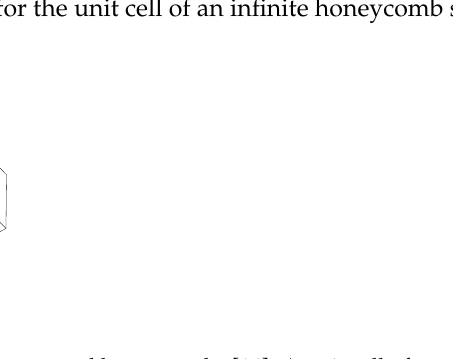
Figure 2. Dimensions of the hexagonal honeycombs [14]. A unit cell of material is